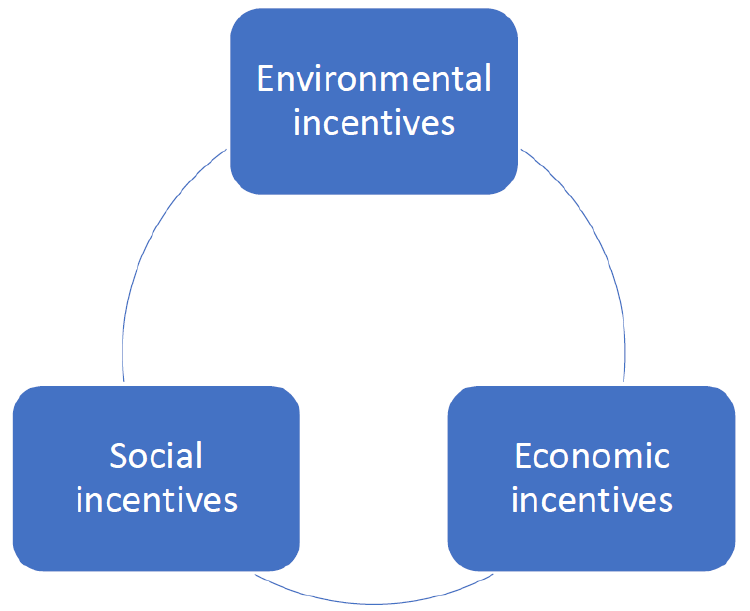
Figure 2. Incentives regarding the switch from consumer to prosumer. Source: own representation based on own research.